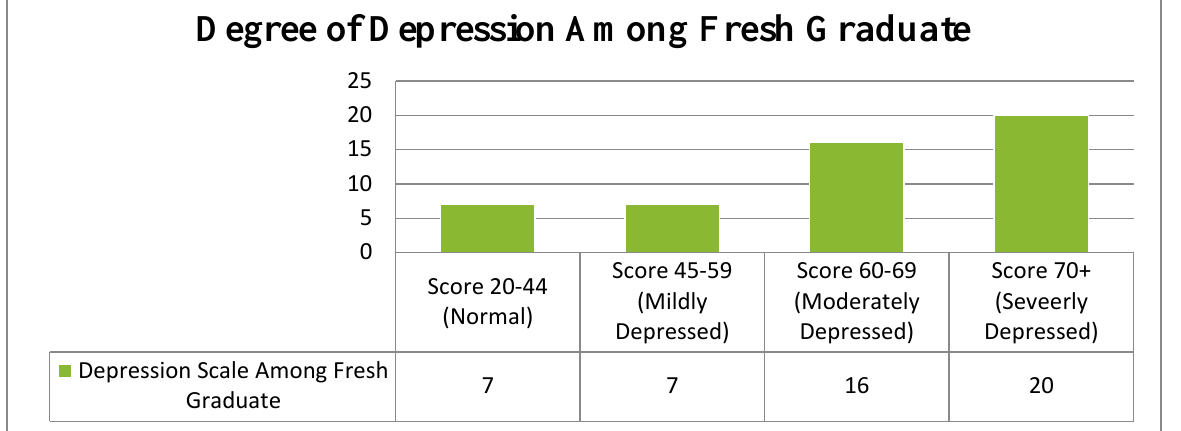
Figure 4 : Figure 4 shows that among the 50 respondents, 7 respondents shows normal symptoms hence scoring below 44 in Zung Depression scale, and 7 fresh graduate shows symptoms of mild depression, the degree of depression reach on the moderate scale by 16 students who experience moderate depressions, and 20